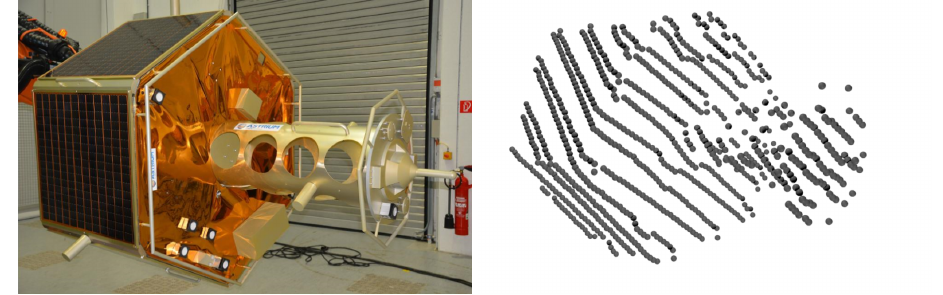
Figure 18: Examplary LiDAR scan: reference photo showing a client satellite mockup at EPOS (left) and a scan set of the LiDAR (right).